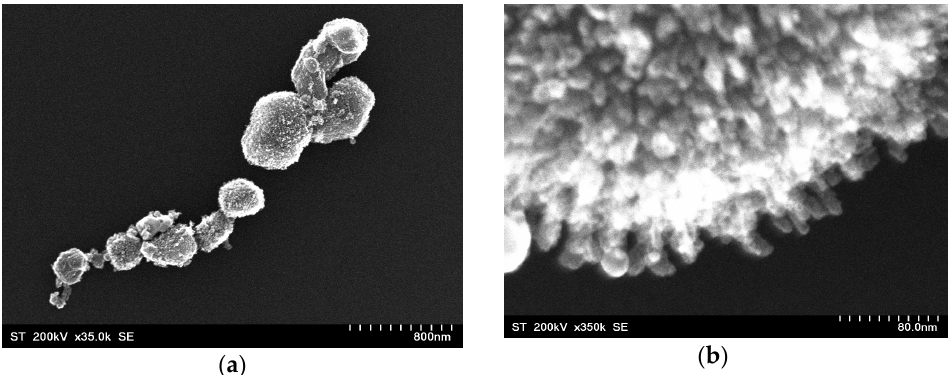
Figure 4. SEM images of CoFe 2 O 4 @SiO 2 @Au 2 nanocomposite ( a ) and the edge of a nanoparticle.